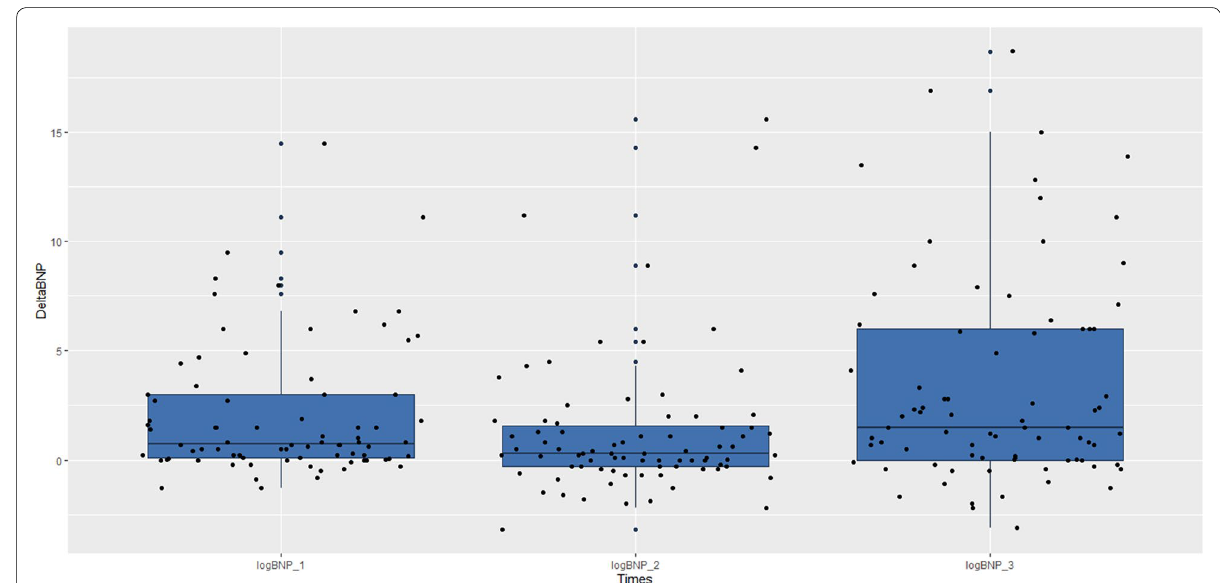
Fig. 3 Comparison between the relative BNP increases between T 0– T 6; T 6– T 24 and T 0– T